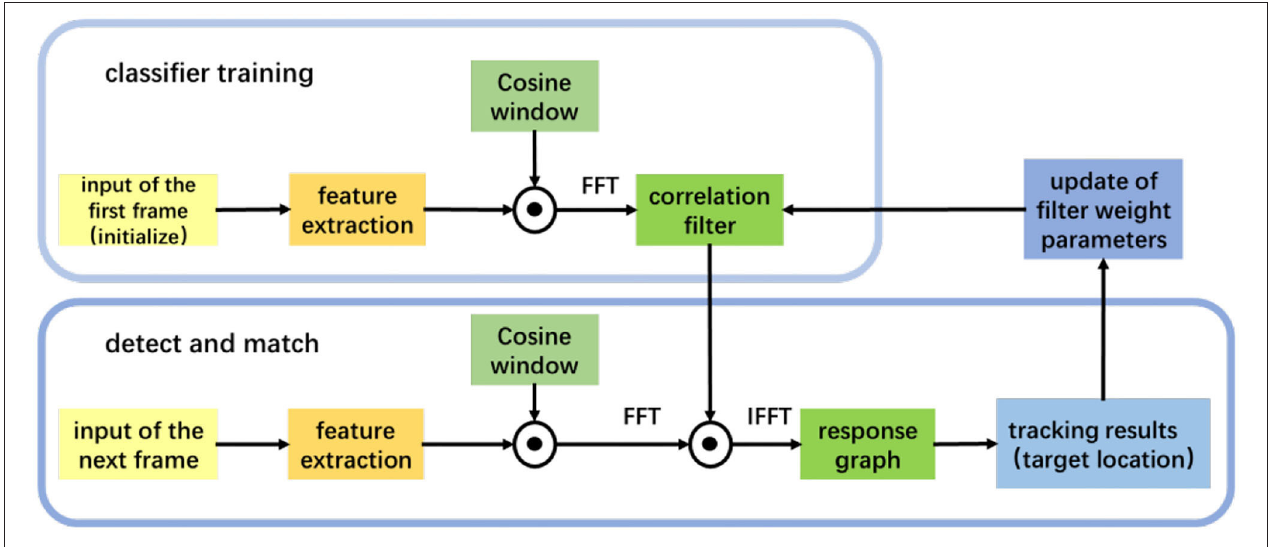
FIGURE 6 | An overall framework of the tracking algorithm.